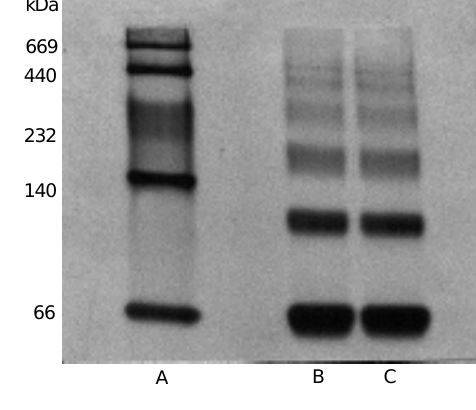
Figure 4. Native polyacylamide gel electrophoresis. Lane A , Na- tive high molecular mass marker (Pharmacia). Lanes B and C , Po- lymerized bovine albumin.